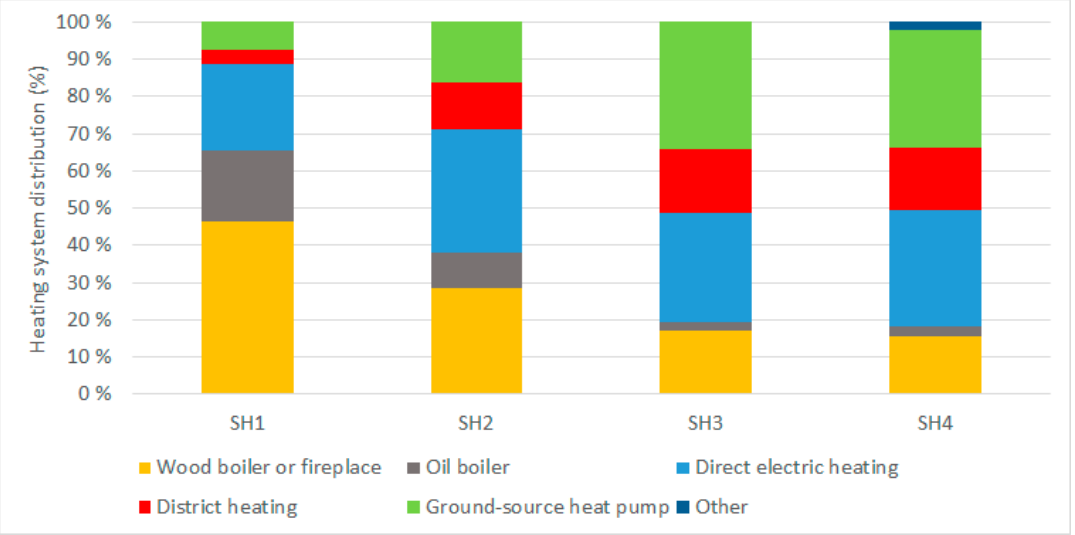
Figure 3. Heating systems in single-family houses. [38].